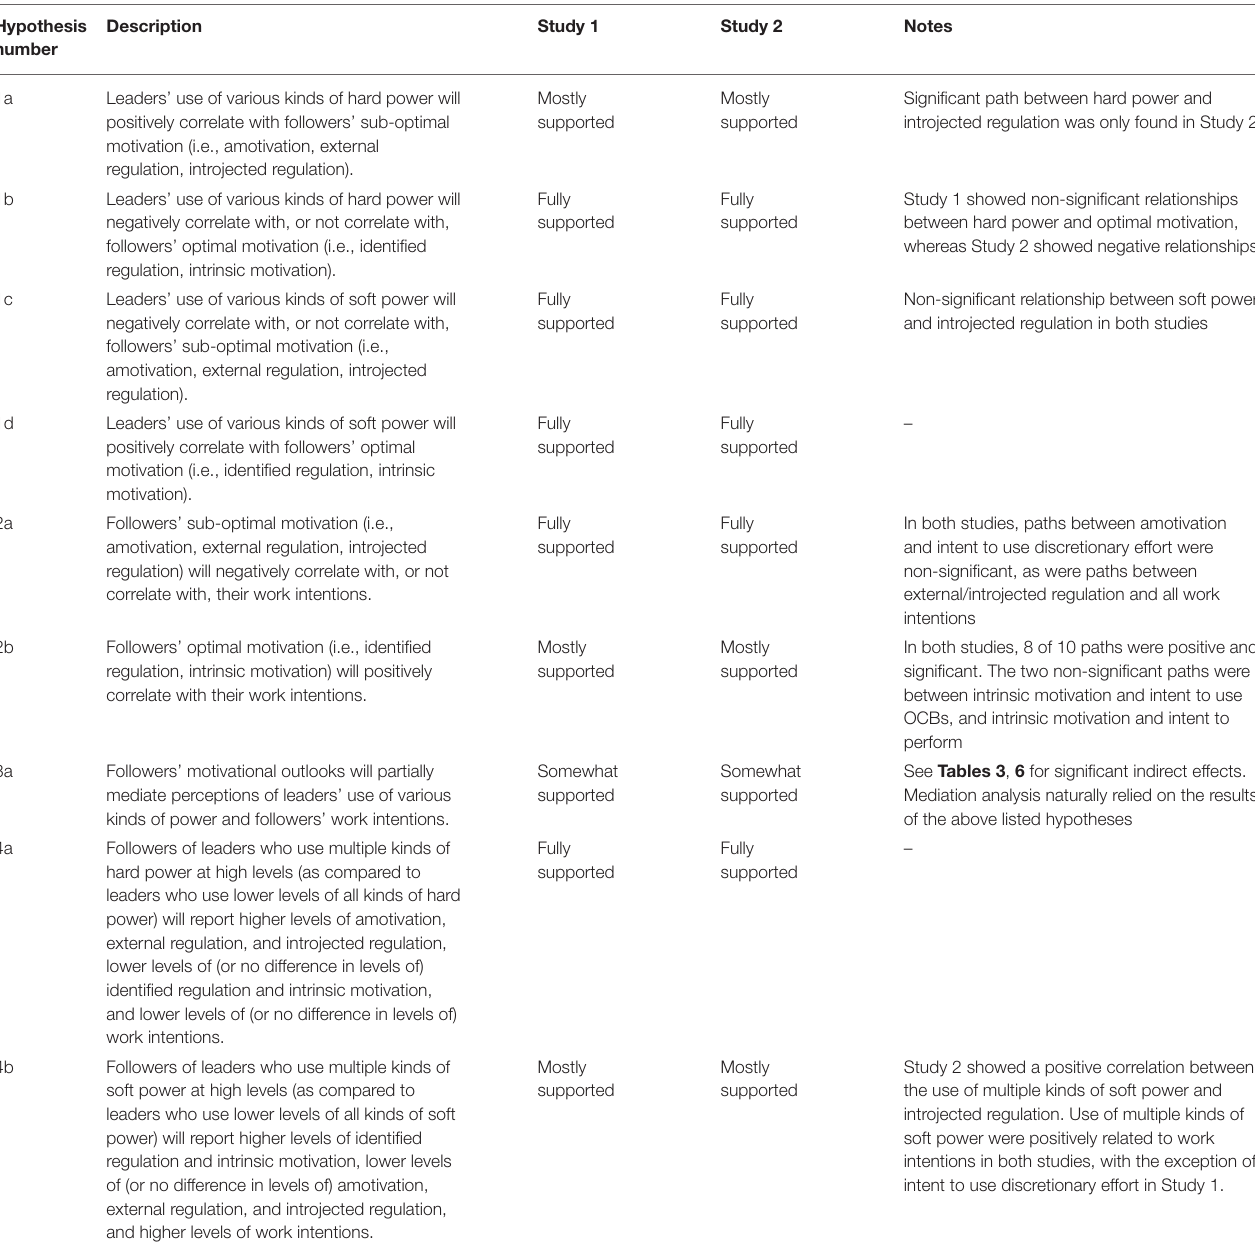
TABLE 9 | Summary of hypotheses and results for studies 1 and 2. Hypothesis